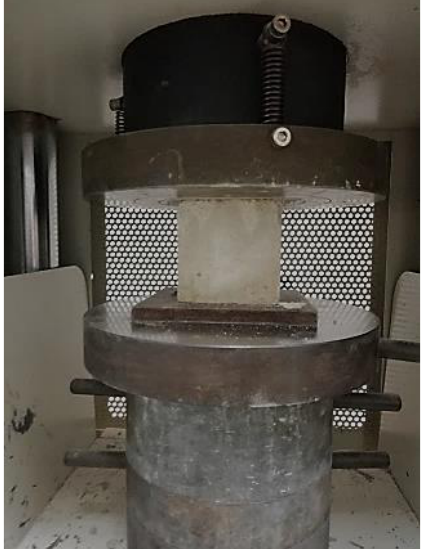
Figure 4. Setup for compression test.